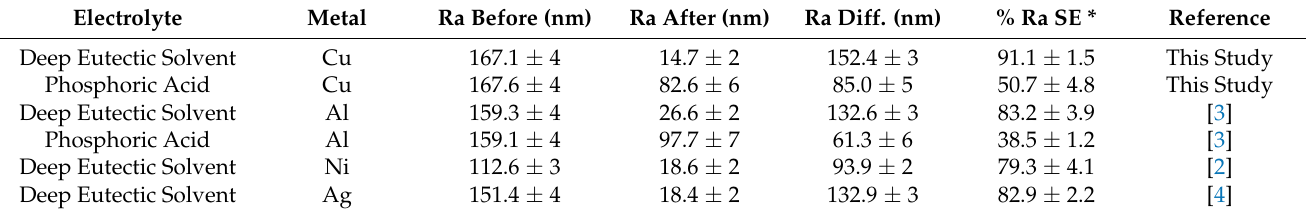
Figure 3. AFM of a copper sample in 2D ( A ) and 3D ( B ) after electropolishing treatments with a deep eutectic solvent, recording an average roughness of 14.7 ± 2 nm via the roughness average method. AFM Z -axis = 100 nm/div. Table 2. Roughness average (Ra) in nm for five copper specimens post and prior to treatments with the respective solutions noted at 70 °C for 900 s. Calculated differences determined % smoothing efficiency (SE) for each sample. Compiled data from external references also noted for comparison.